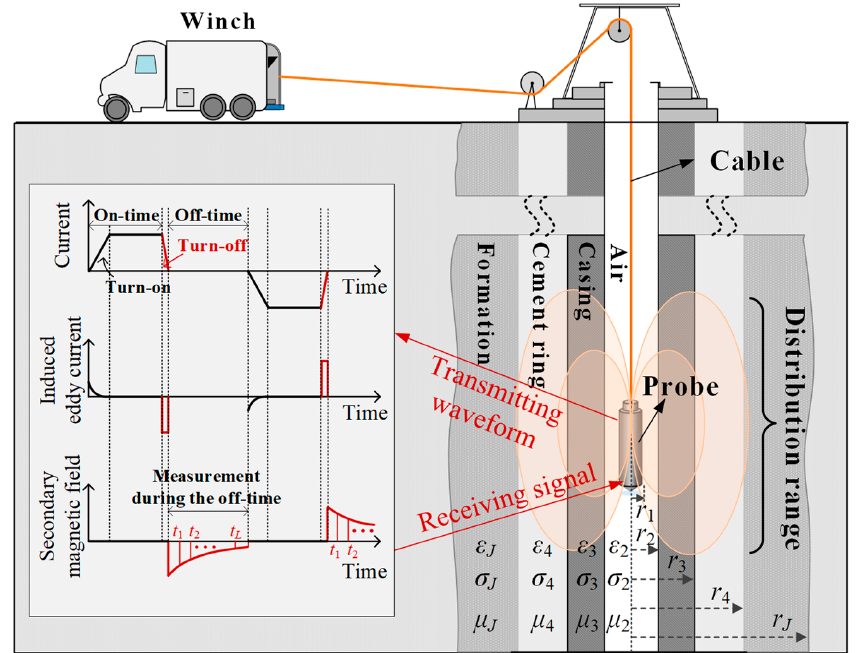
Figure 1. PEC system for borehole casing inspection.